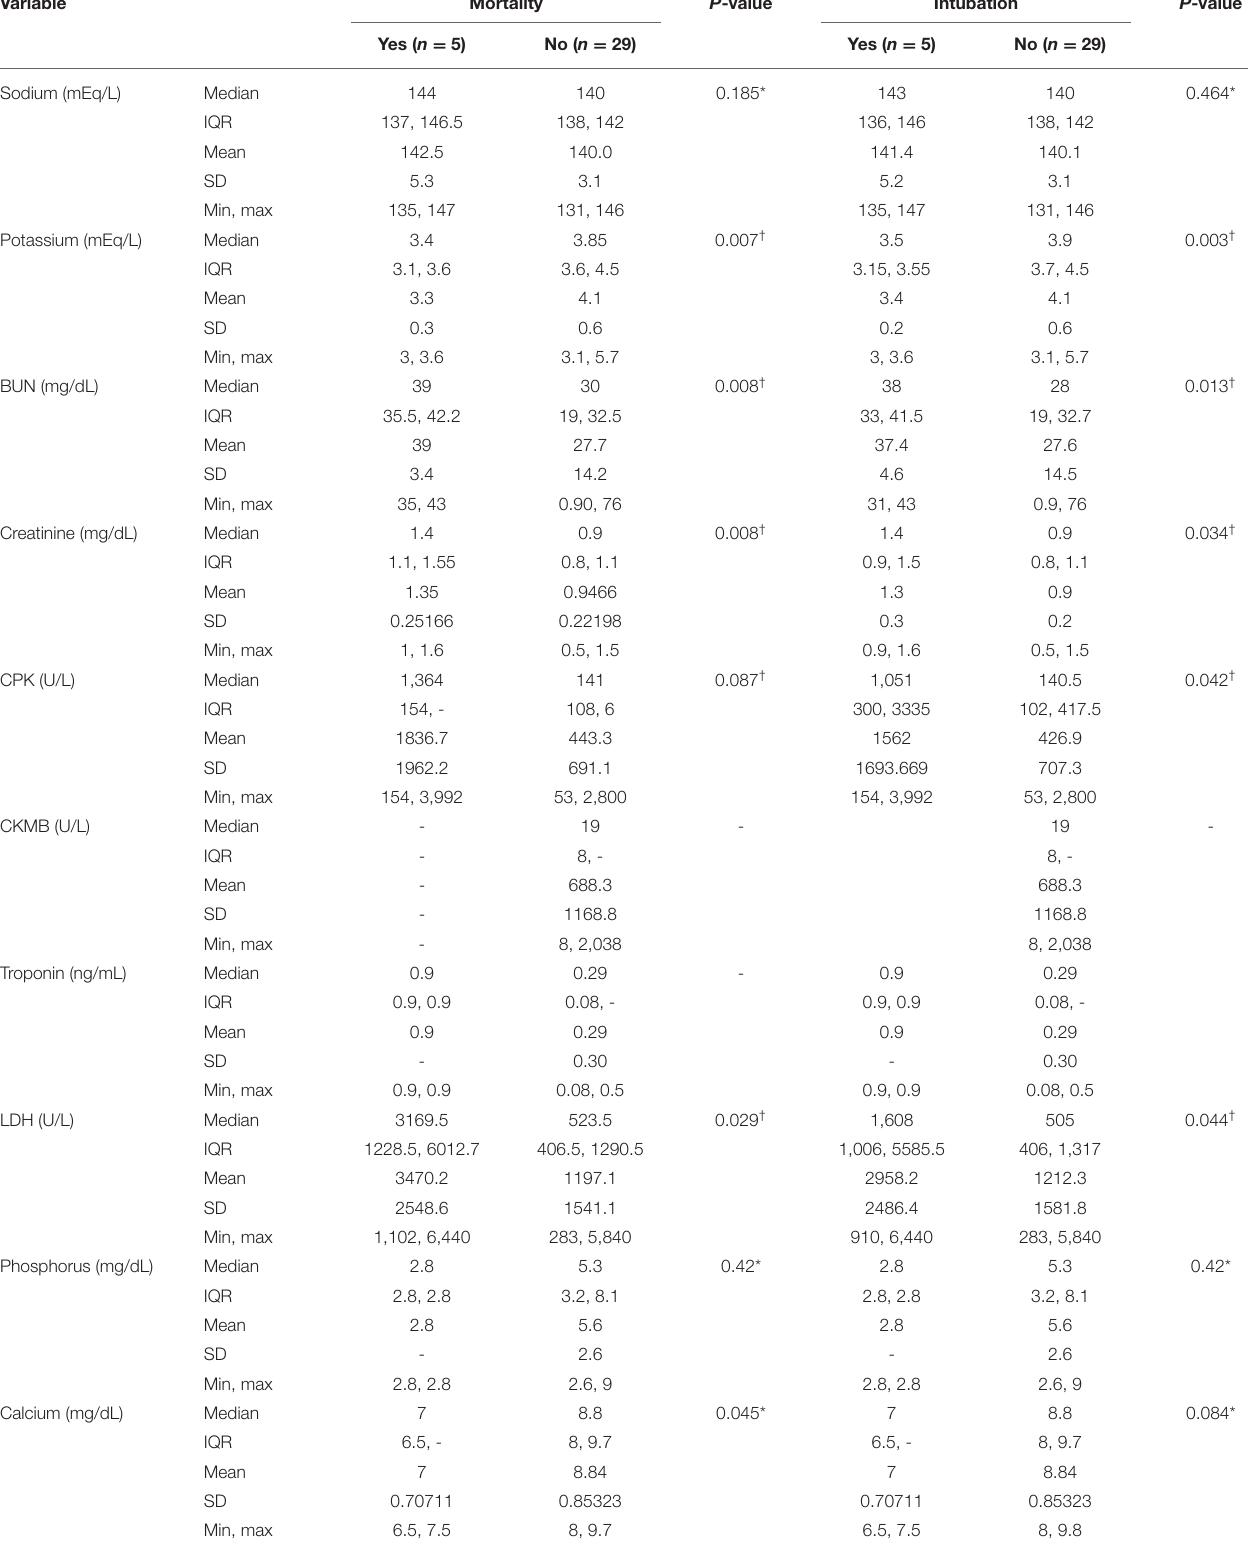
TABLE 4 | Lab test results in patients who eventually underwent intubation and those who were expired.